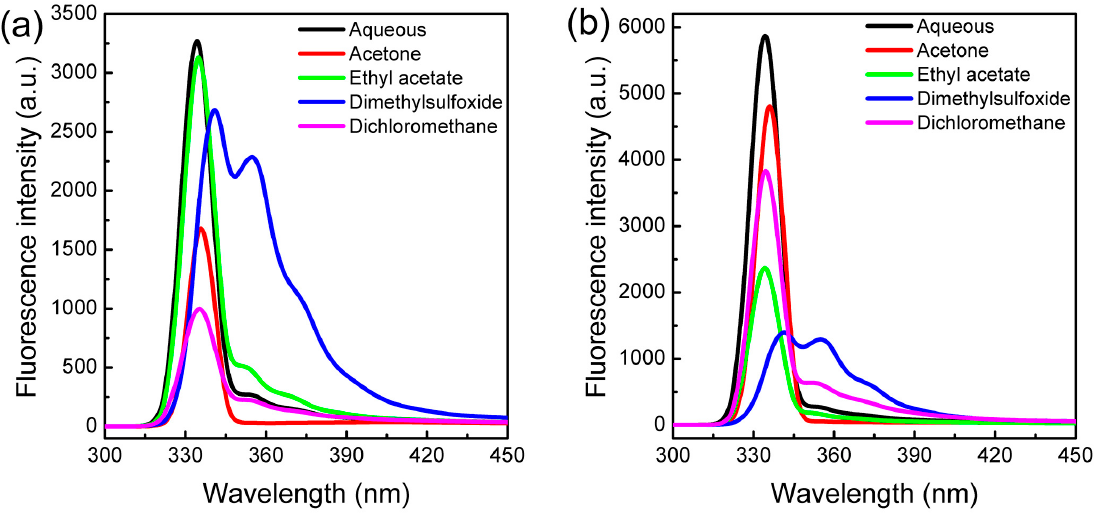
Figure 5. Fluorescence spectrum of ( a ) NOWPU-0.5 and ( b ) NOWPU-1.0 with various solvents (Concentration of NOWPUs = 10 − 3 g/mL in water, λ ex of NOWPU-0.5 = 331 nm, λ ex of NOWPU-1.0 = 332 nm).